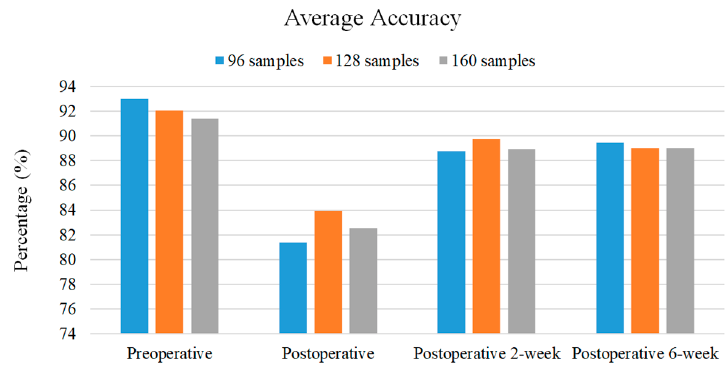
Figure 10. The average accuracy of proposed algorithm with different window sizes in each phase.